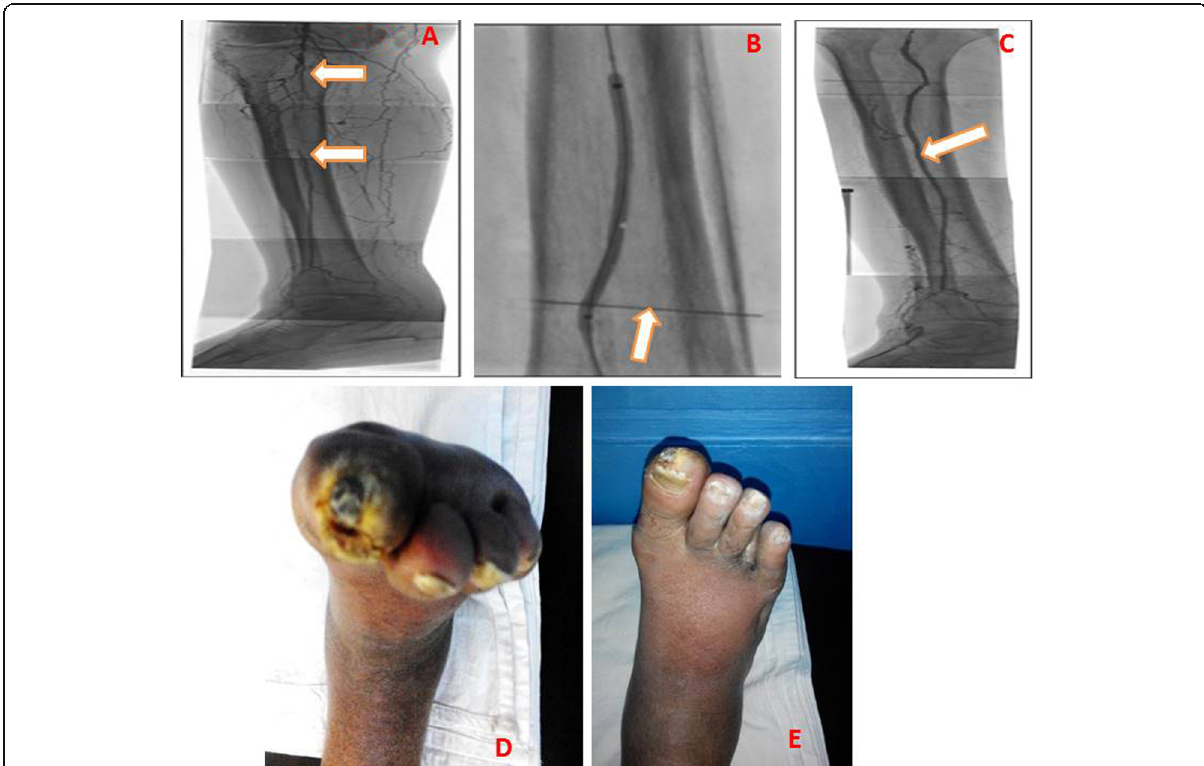
Fig. 5 A 56-year-old male patient presented with unhealed Rt. foot ulcer affecting mainly the big toe: a Pre-procedure angiogram, lateral view where the two arrows indicate the markedly stenosed segment of peroneal artery. b During procedure and the balloon is noted inflated inside the stenosed arterial segment. c Post-procedure angiogram with accepted recanalization of the previously stenosed arterial segment. d , e The foot at pre- and